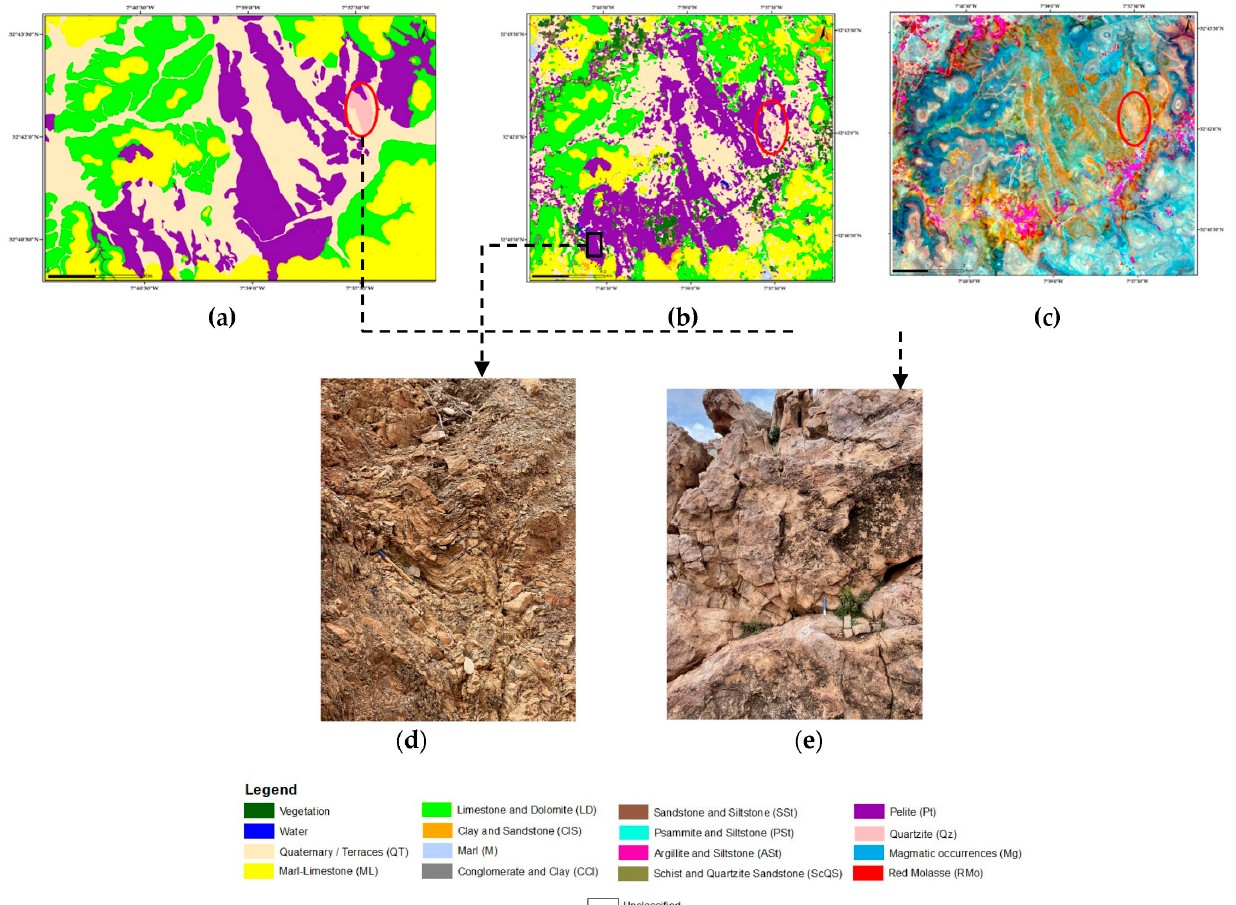
Figure 11. Validation of the proposed approach at the magnified area of Oued Quibane: ( a ) existing geological map; ( b ) lithological map using DST; ( c ) enhanced color composite and field photographs of the basement outcrops: ( d ) pelite (Pt) and ( e ) quartzite (Qz).